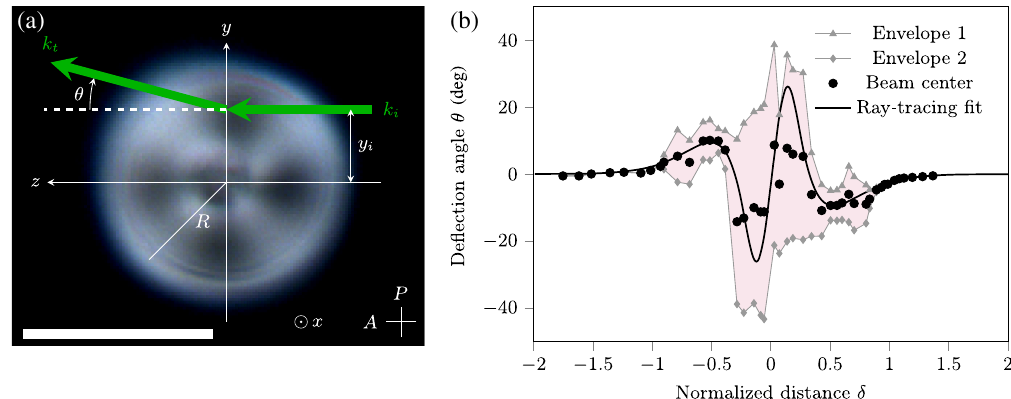
FIG. 9. Experimental measurements of incident beam deflection and lensing with a theoretical ray-tracing fit for a toron at no electric field. (a) A schematic representation of the coordinate system and parameters used for data measurement. The incident beam k deflected by an angle θ from the incidence trajectory, which is depicted as a white dashed line segment. The deflected ray k represent the center of a deflected beam profile or its half-intensity-maximum envelope rays. (b) Deflection angles for the beam envelope and beam center rays plotted against the normalized distance δ ¼ y theoretical ray-tracing fit for center angles is plotted as the black curve. Negative angles in (b) correspond to a clockwise deflection of k as indicated in (a). The scale bar ’ s length represents 100 μ